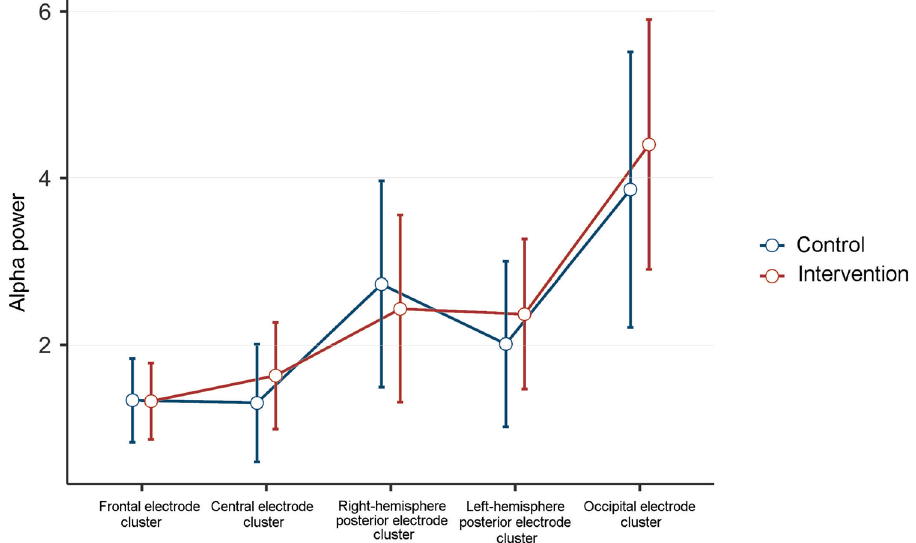
Figure 2. Intervention effects on child alpha power at age 6 months measured by EEG (intervention n = 17, control n = 14). Fitted model plot over time by electrode cluster and randomization status ( p = 0.633, partial η 2 =